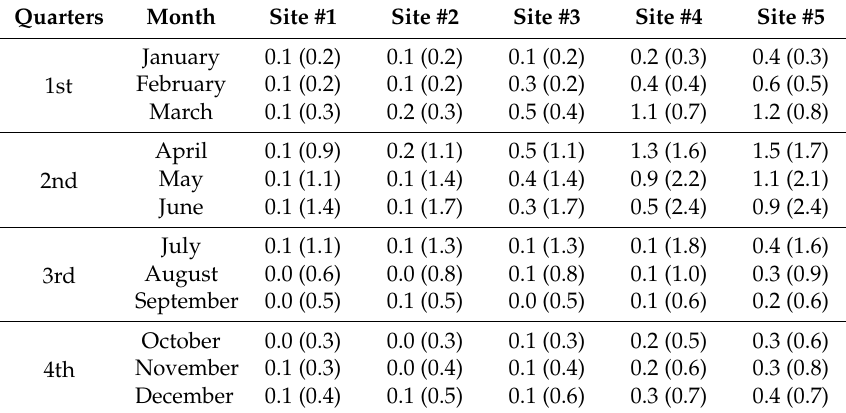
Table 4. Median monthly flow statistics calculated from SWAT-simulated pre-settlement flow (shown parenthetically) and observed developed flow in Hinkson Creek, MO, USA.